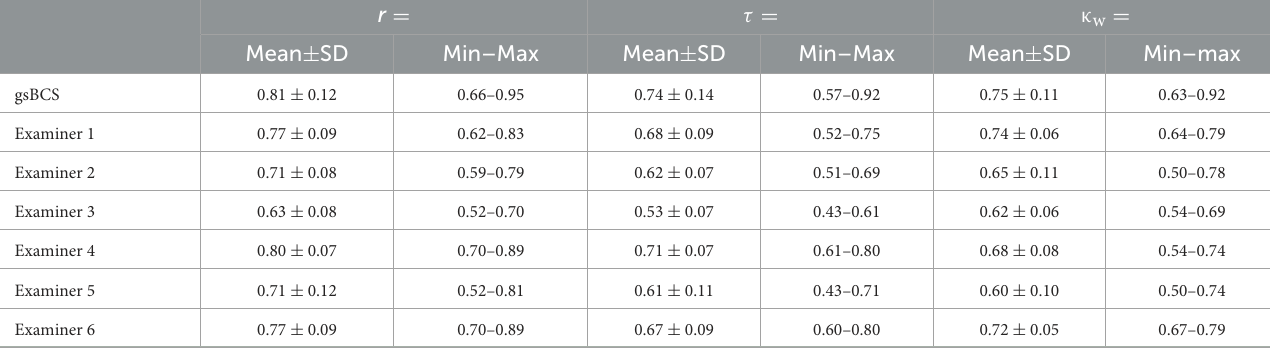
TABLE 4 Agreements [Spearman’s rank correlation coefficient (r), Kendall’s rank correlation coefficient ( τ ) and Cohen’s weighted kappa ( κ w )] of all examiners with the gsBCS (line “gsBCS”; n = 6), and of the individual examiners with each of the other examiners (lines “examiner 1” to “examiner 6”; n = 5 each).